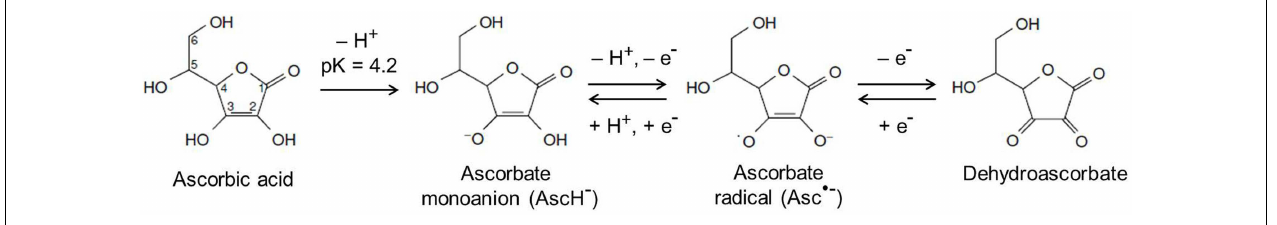
FIGURE 2 | Chemical structures of ascorbate and its oxidation products . At physiological pH, ascorbate exists as the ascorbate monoanion and can undergo two consecutive, reversible, one-electron oxidations to produce the ascorbate radical and dehydroascorbate, respectively. Adapted from Kall